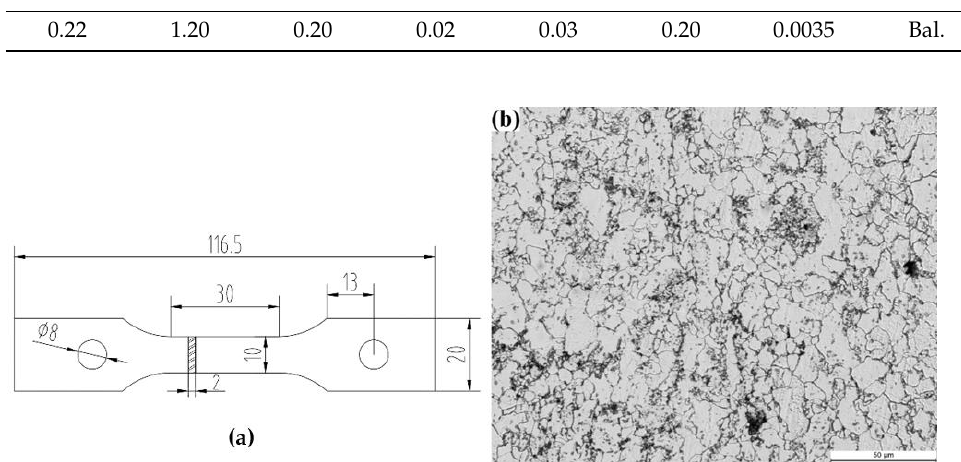
Figure 1. ( a ) Dimensions of thermal tensile specimen (mm) and ( b ) initial OM image of the studied 22MnB5 boron steel.